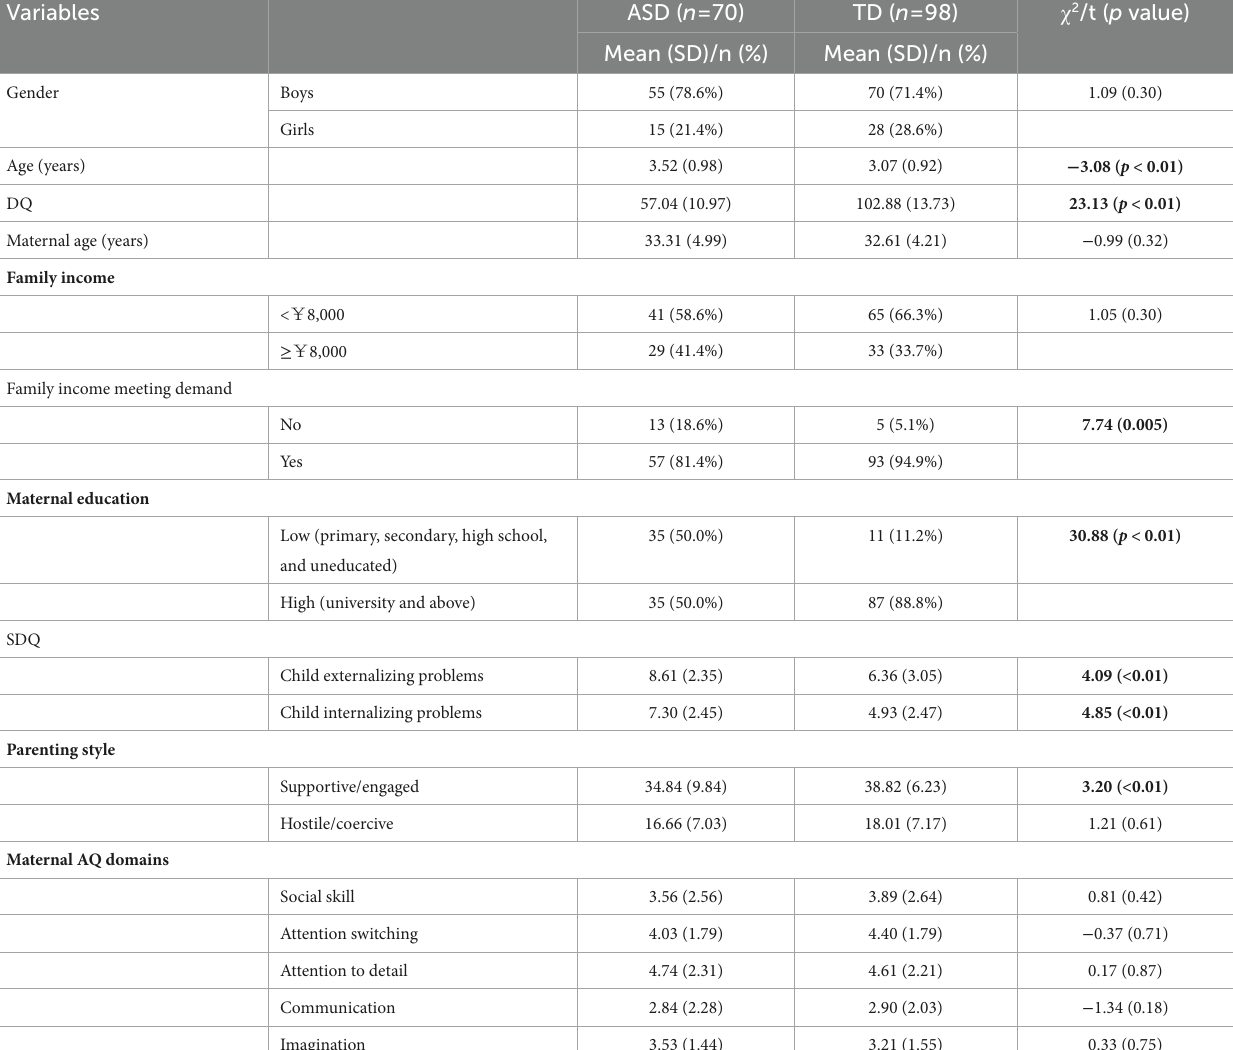
TABLE 1 Descriptive statistics for autism and control groups.